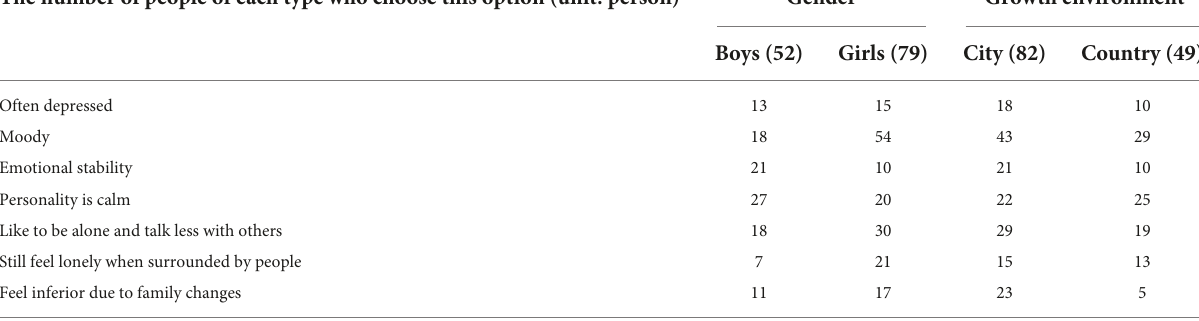
TABLE 13 Intra group comparative data on emotional state of college students from divorced families. The number of people of each type who choose this option (unit: person)